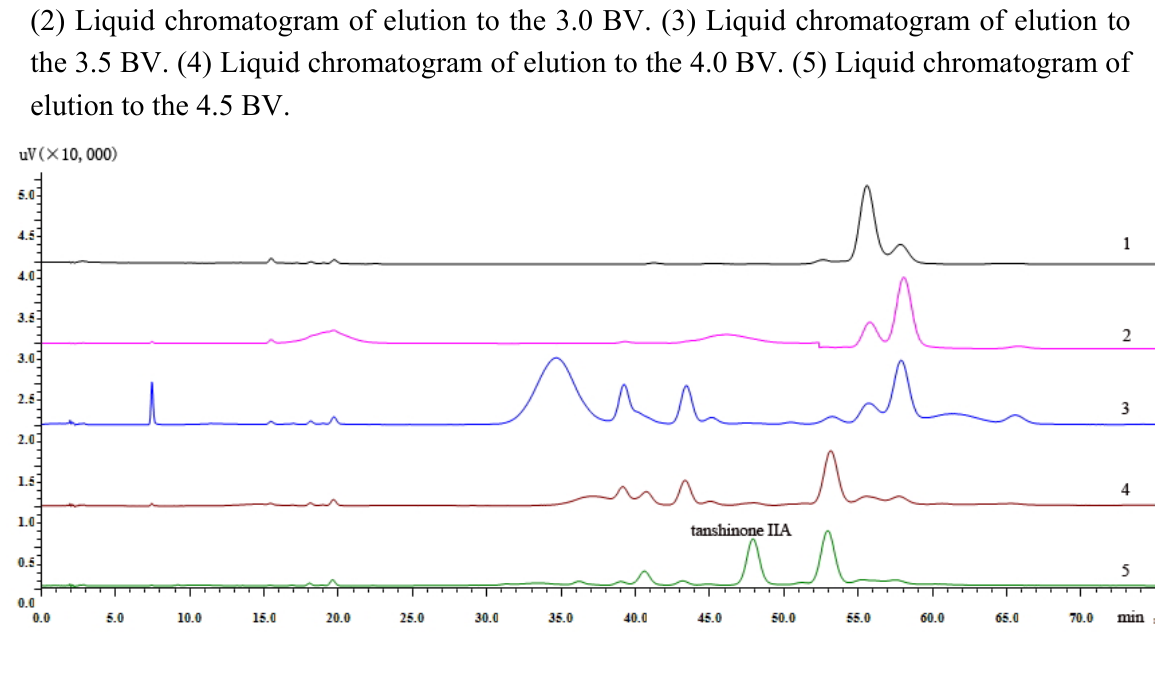
(2) Liquid chromatogram of elution to the 3.0 BV. (3) Liquid chromatogram of elution